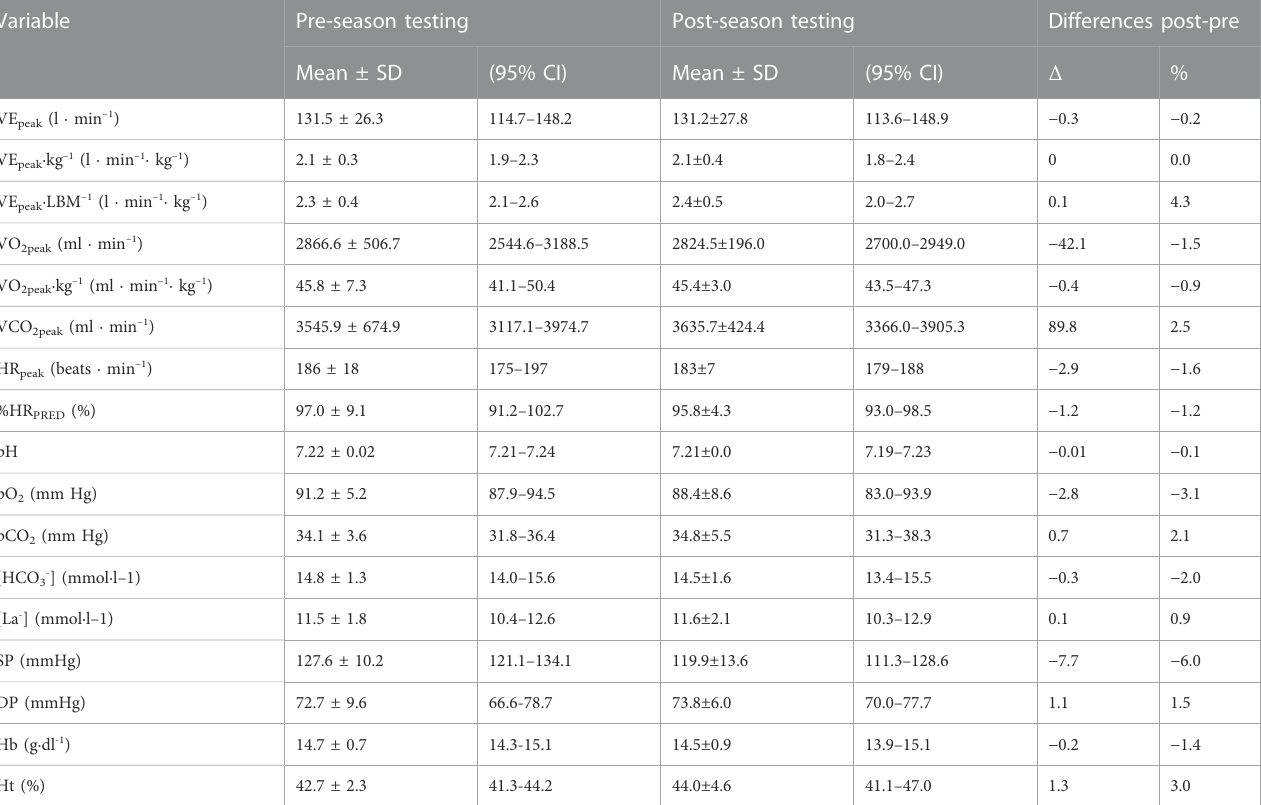
TABLE 4 Pre- and post-season testing mean ± standard deviation and 95% CI of cardio-respiratory responses, blood gas metrics and hematological variables, lactate ions concentrations measured at the Wingate test and blood pressure.